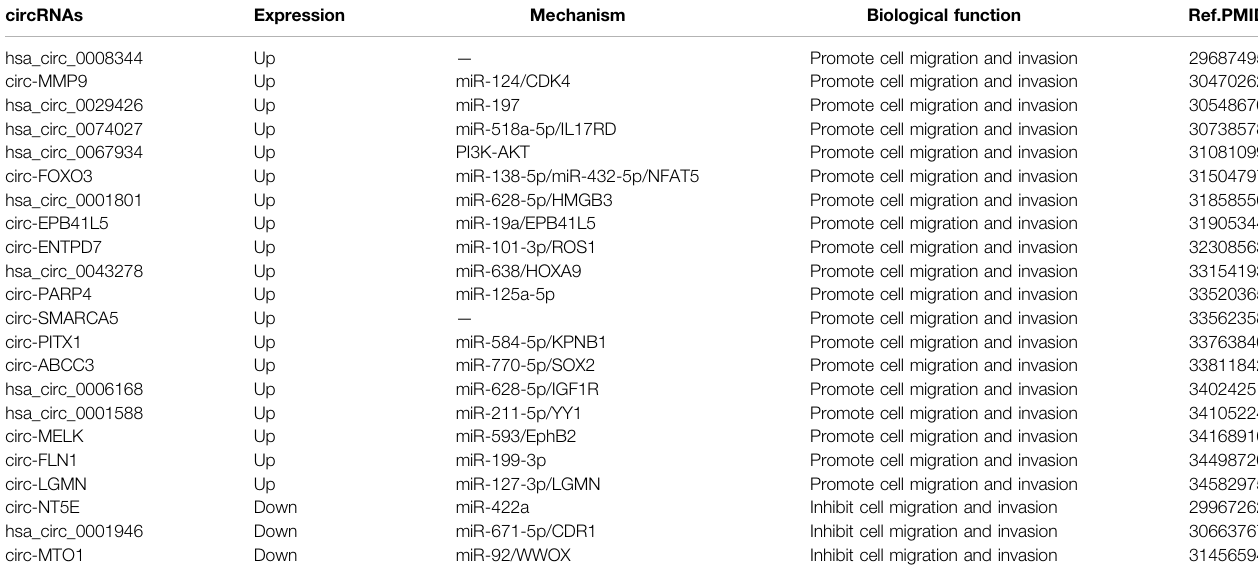
TABLE 2 | The migration and invasion-related circular RNAs in GBM.